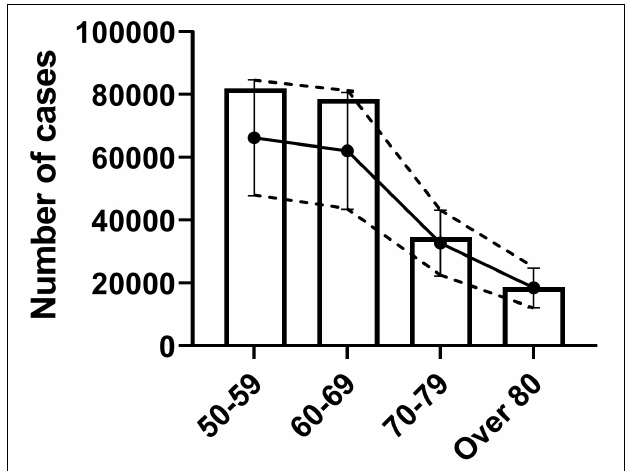
FIGURE 3 | Verification of confirmed cases as epidemic parameter for true infection cases. Analysis of similarity between reported confirmed cases and age-specific estimated true infection cases. Estimated true infection cases with standard error are shown as dotted lines with error bars. Bar graph shows the reported confirmed cases by age